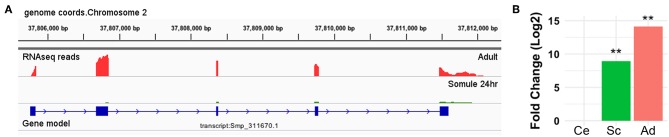
Smp_311670 is up-regulated in intra-mammalian stages. (A) Graphical representation using Integrative Genomics Viewer (IGV) of the gene/transcript model Smp_311670 is shown in blue where solid boxes represent exons and the lines and arrows represent introns and the direction of transcription, respectively. The coverage plots above the gene model represent transcriptome (RNA-seq) sequencing reads from two different life cycle stages: adult worms (red) and 24-h schistosomula (green). (B) Bar plot showing the relative gene expression levels of Smp_311670 across three life cycle stages, cercariae (fresh water larvae), 24-h schistosomula (intra-mammalian, skin, and migrating), and adult worms (intra-mammalian, mesenteric veins). Values are presented as Log2 fold change relative to cercariae. Ce = cercariae, Sc = 24-h schistosomula, Ad = adult, **Bonferroni adjusted P < 0.01.